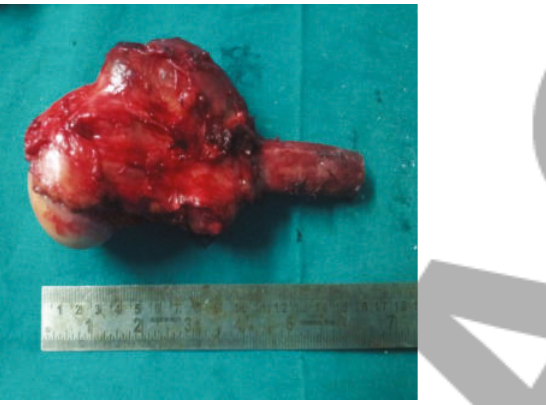
Figure 12: Excised mass lesion.